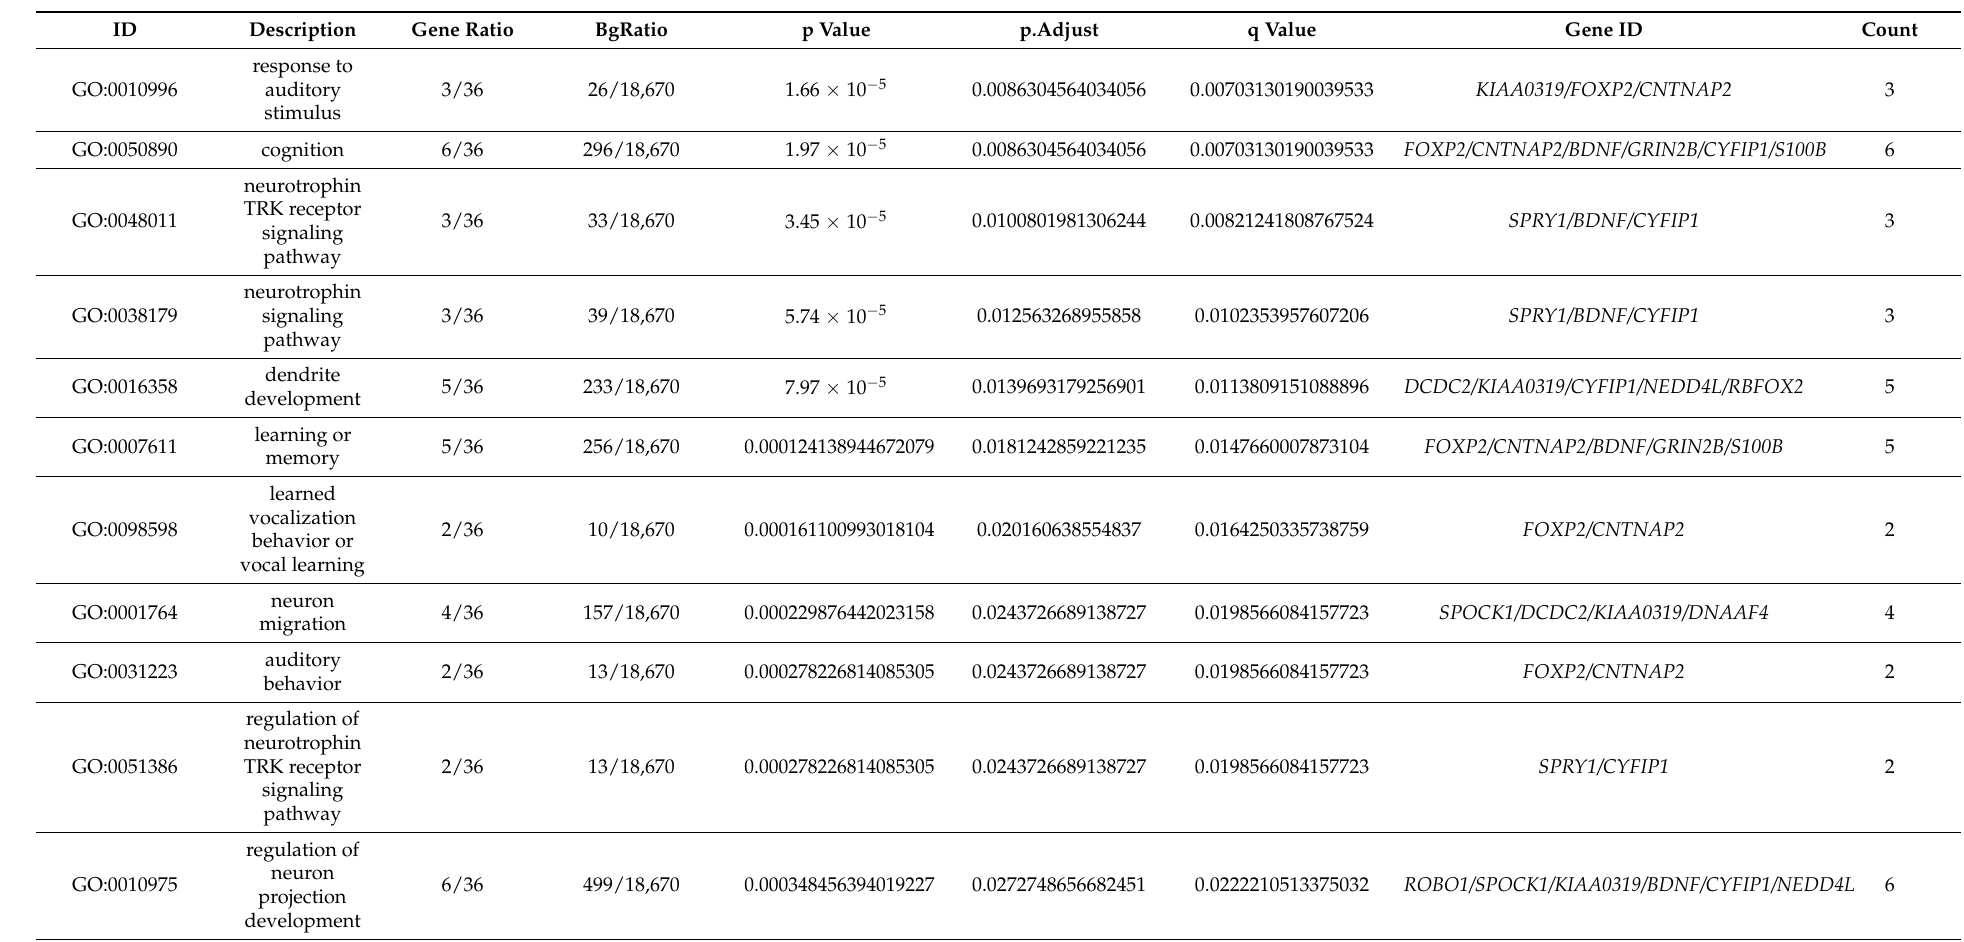
Table A1. Original data pertaining to Figure